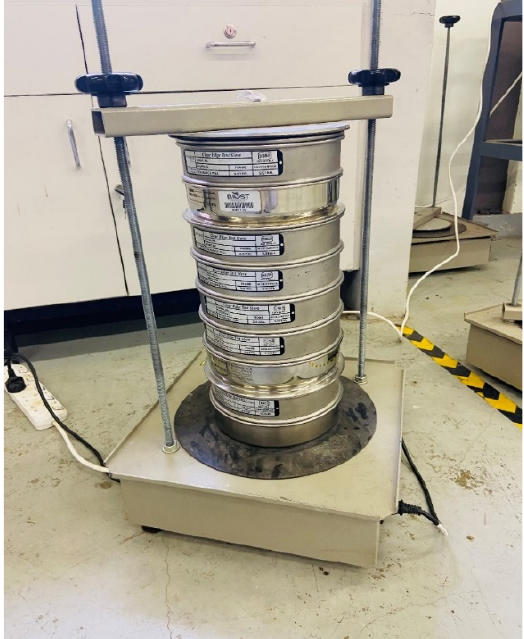
Figure 3. Sieve analysis method employed. Table 4. Planetary mill test conditions and varied parameters used in the experiments.